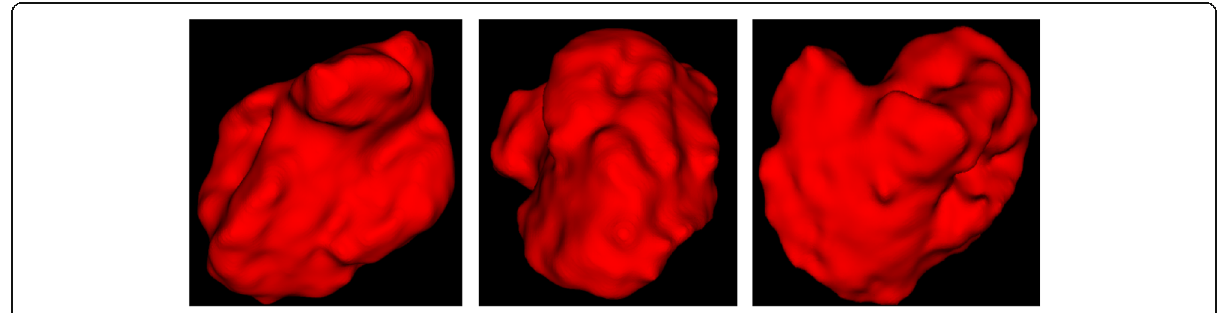
Fig. 5 Three-dimensional intracranial hematoma model